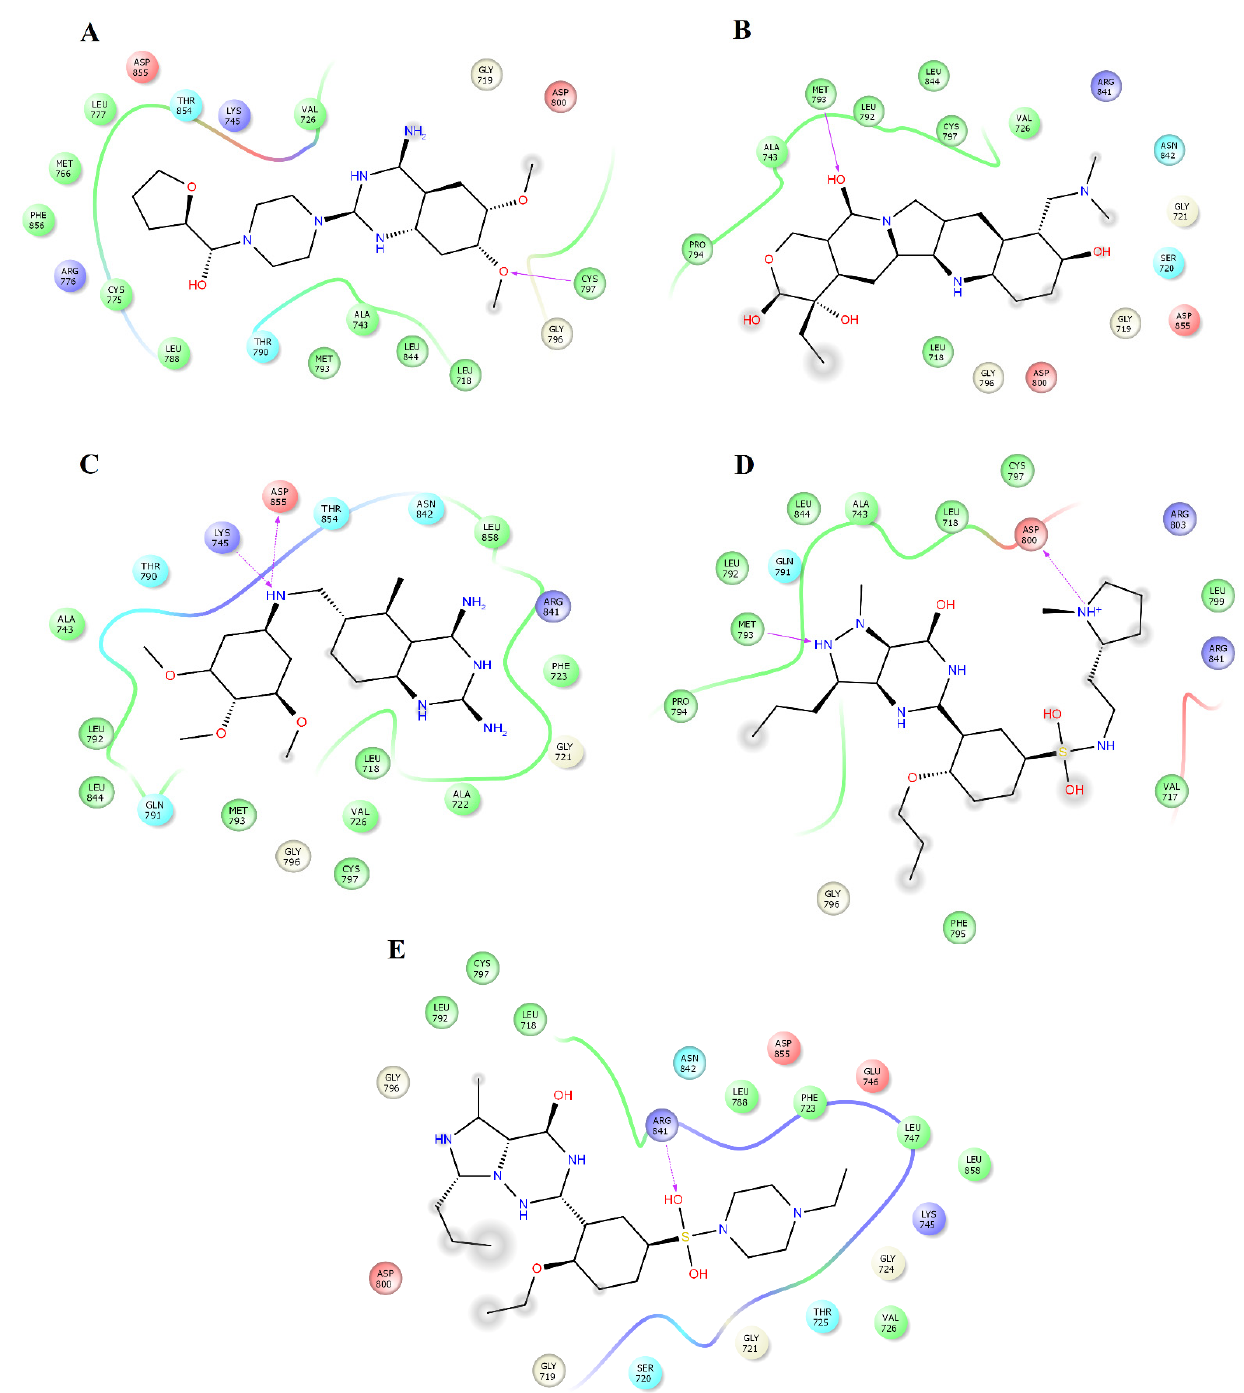
Figure 6. Interactions of the complexes between EGFR and terazosin, topotecan, trimetrexate, udenafil, and vardenafil. Binding complex for EGFR terazosin ( A ); EGFR topotecan ( B ); EGFR trimetrexate ( C ); EGFR udenafil ( D ) and EGFR vardenafil ( E ).